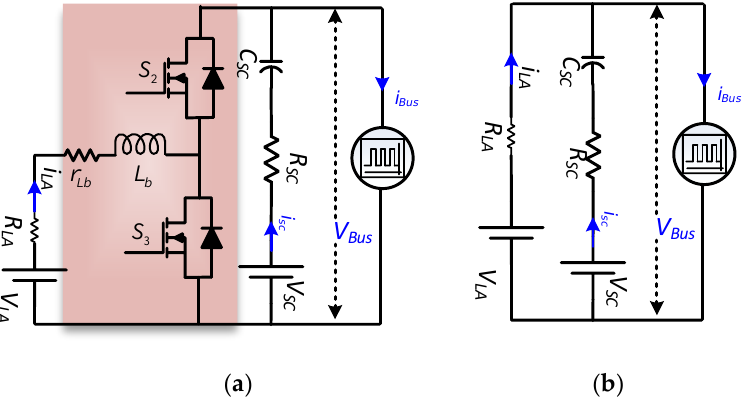
Figure 11. ( a ) Battery semi-active HESS circuit ( b ) equivalent circuit of ( a ).